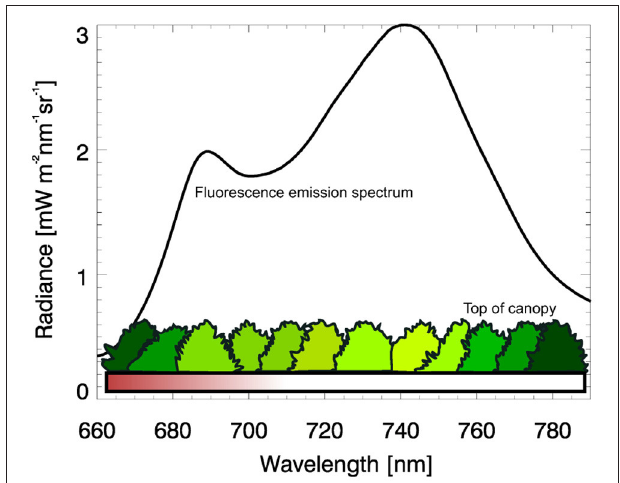
FIGURE A1 | Fluorescence emission spectrum at the top of canopy layer in mW cm − 2 sr − 1 nm − 1 ( Rascher et al., 2009).